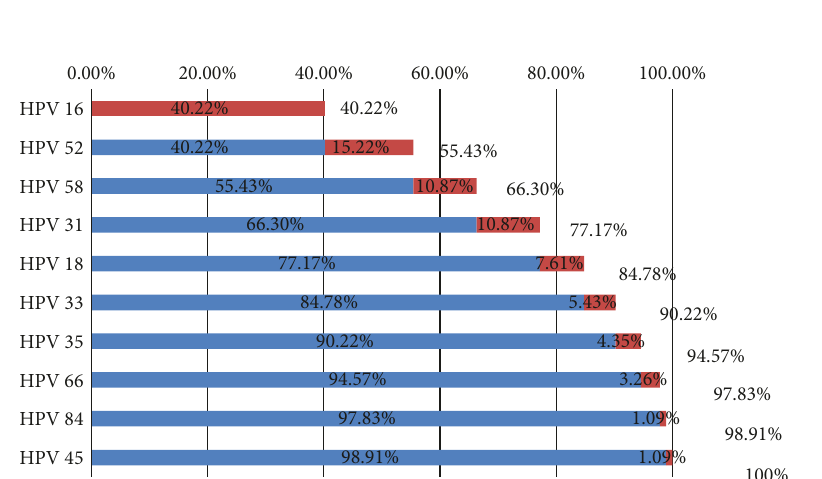
Figure 1: Cumulative graph of human papillomavirus (HPV) genotype distribution among the analyzed high-grade squamous intraepithelial lesion (HSIL) clinical specimens. To inspect HPV distribution, HPV-positive specimens were analyzed in descending order. It is shown as a cumulative graph to check the degree of occupation.